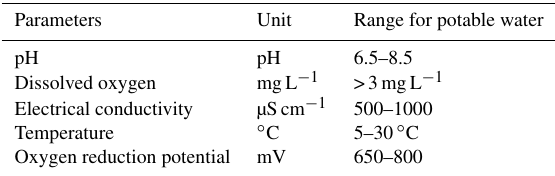
Fig. 1b for Arduino MEGA 2560 with a sensor stamp.